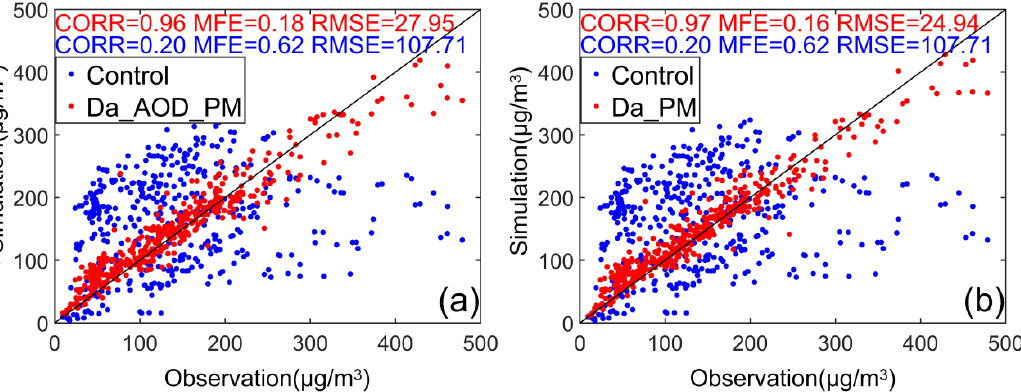
Figure 3. Comparison between the PM 2.5 measurements and the PM 2.5 in ( a ) the control IC (blue points) and Da_AOD_PM analysis (red points). ( b ) Control IC (blue points) and Da_PM analysis (red points).